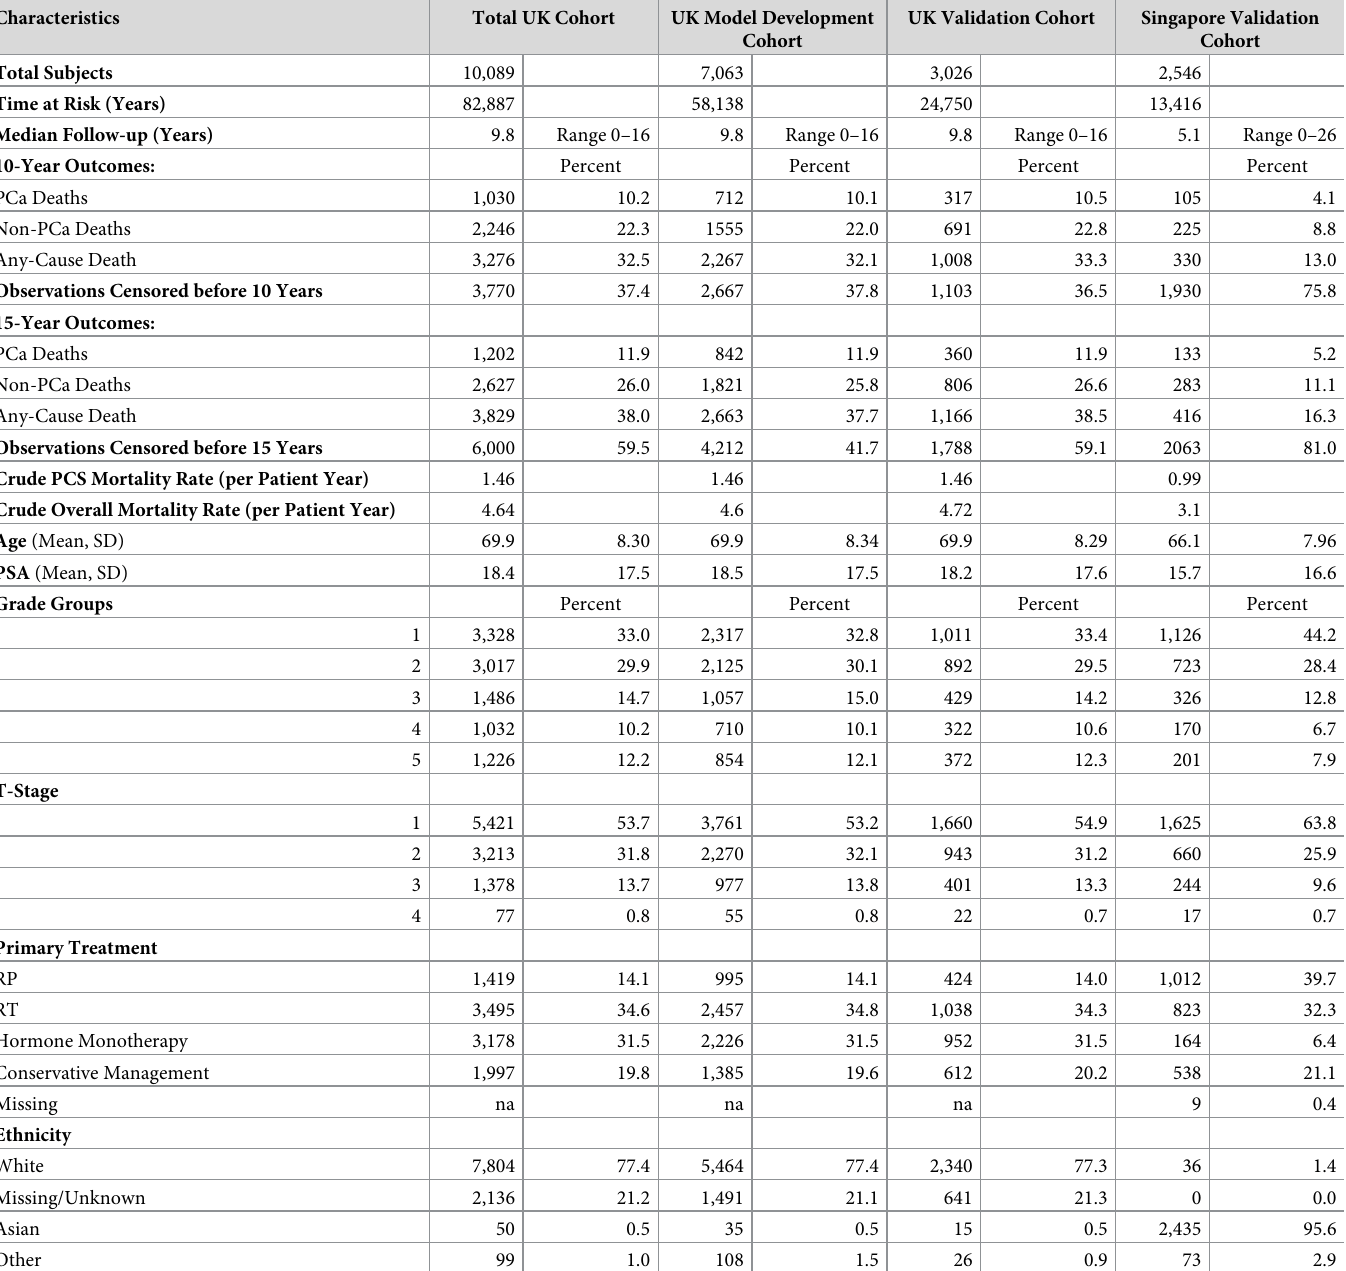
Table 1. Baseline cohort characteristics in the UK cohort overall, model development and validation cohorts, and the external Singapore cohort.